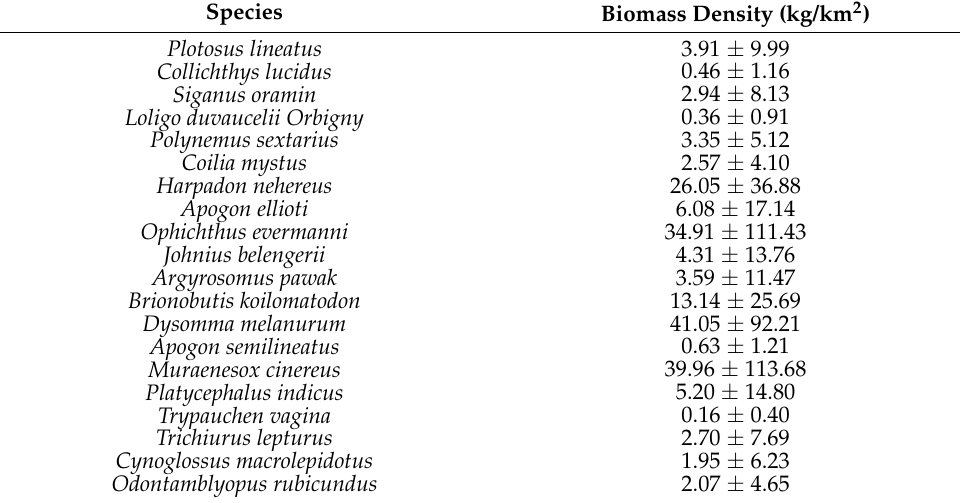
Table A1. The acoustically-derived biomass density of each fish species (mean ±